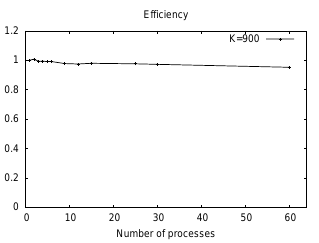
Figure 5. Results of the speed-up test for the McFadden problem. Data are grouped in five histograms. Each one represents the speed-up vs. the num- ber of processes involved in the compu- tation, for a fixed K .